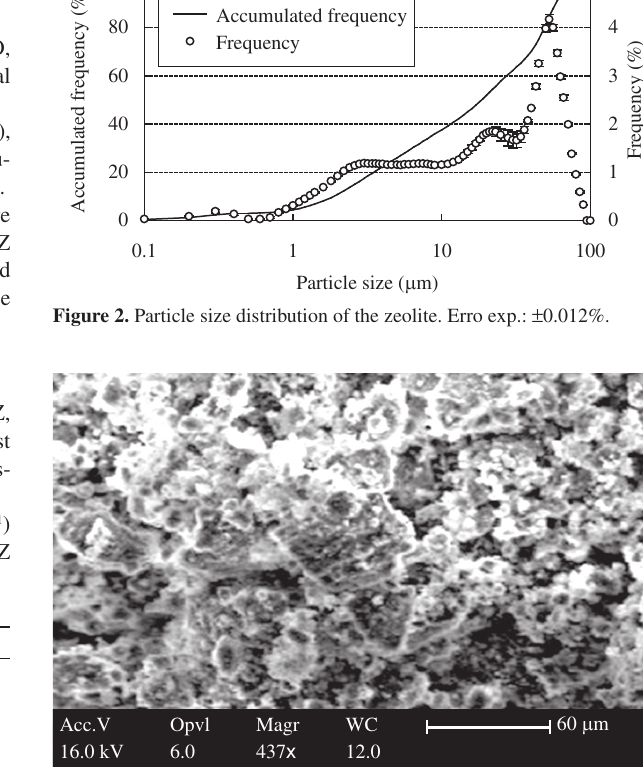
Figure 3. Image of zeolite particles obtained by scanning electron microscopy. Bar length is 50 µ m. and the magnification 487 x